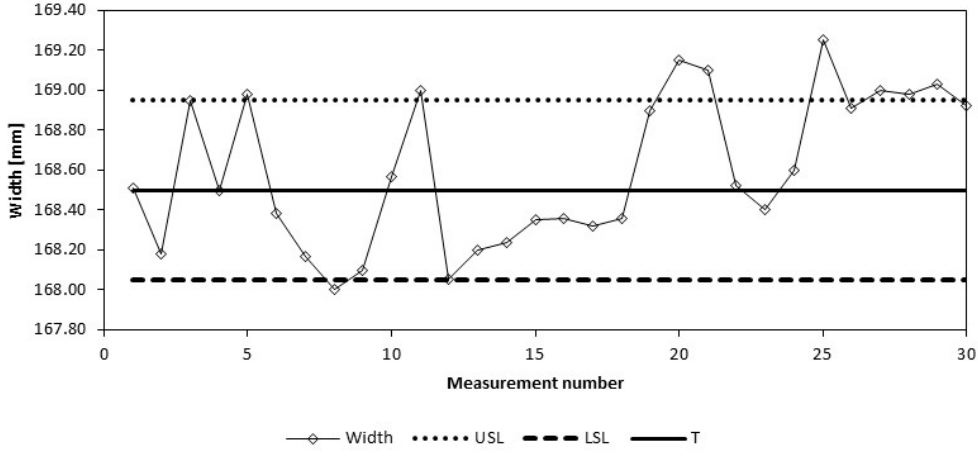
Figure 4. Measured data for the width parameter, first day.